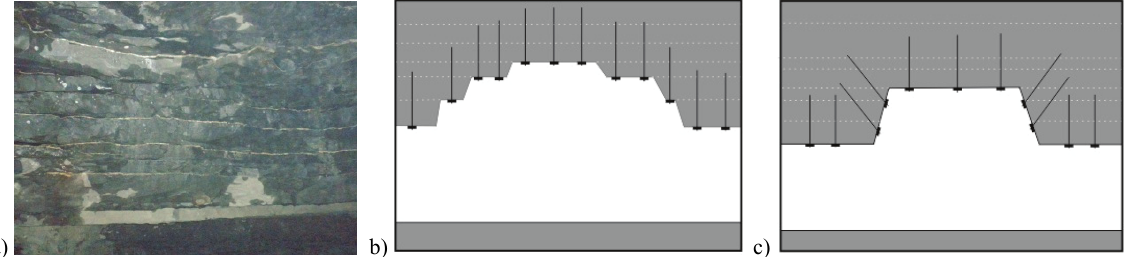
Fig. 3. Roof stratification; a) room excavation roof; b) excavation rebuild with rock layers forming stairs, c) excavation rebuilt with the occurrence of a void in the shape of a “bell” (photo by K.